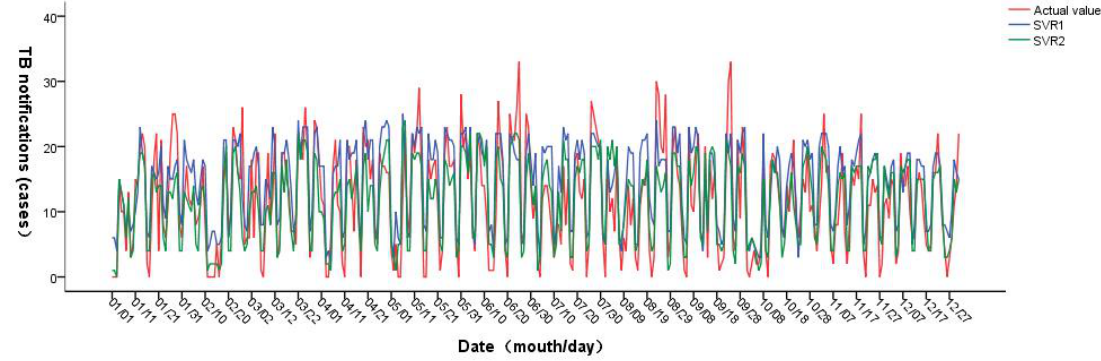
Figure 3. Prediction results of support vector regression.